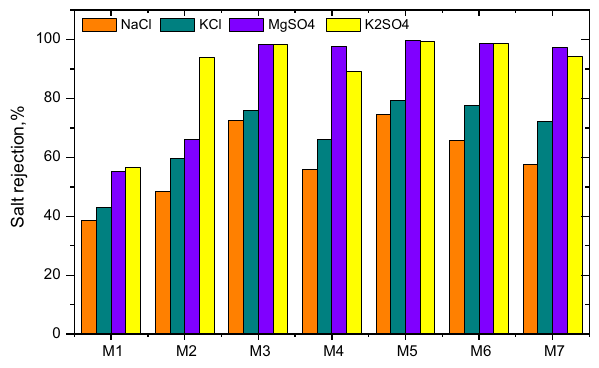
Fig. 9 Salt rejection of the all fabricated membranes (feed concentra- tion of 200 mg/l for